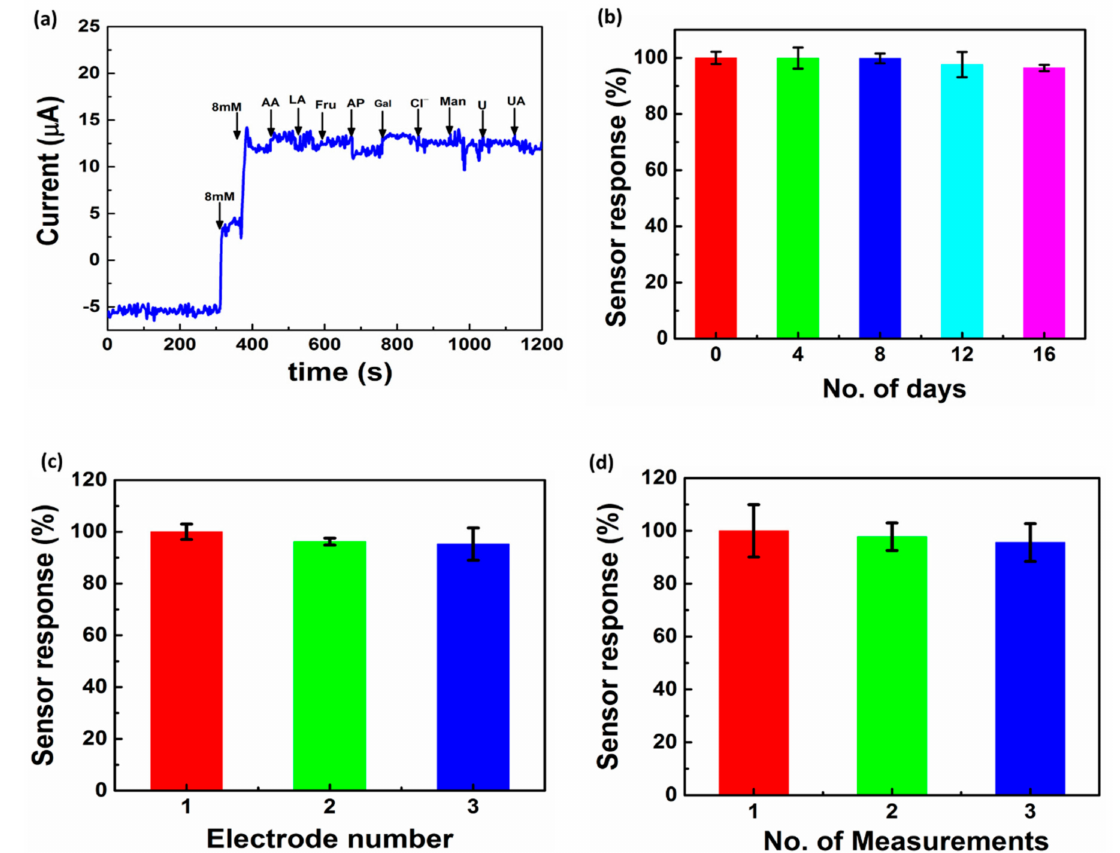
Figure 7. Interference study of the sensor in the presence of common interferents (AA: ascorbic acid, LA: lactic acid, Fru: fructose, AP: acetaminophen, Gal: galactose, chloride (Cl − ), Man: mannose, urea (U) and uric acid (UA) present in ISF, carried out in 10 × PBS at pH = 7.4. ( a ). Storage stability of the microneedles carried out in 10 × PBS (pH = 7.4) at 24 ◦ C ( b ), reproducibility ( c ) and repeatability ( d ) of the MNEAs studied at a concentration of 7 mM or 126.12 mg/dL of glucose, at an applied external potential of +0.12 V. Each data point represents the average of three independent experimental values ( n = 3), with the range indicated in the standard error